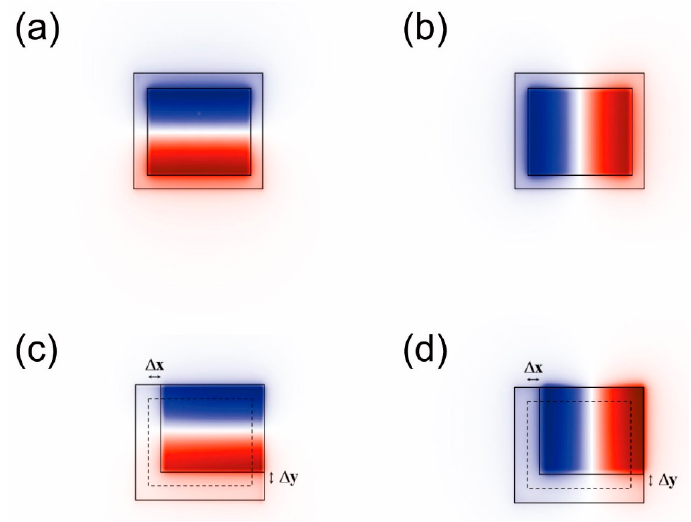
Figure 2. The dominant electric field ( E z ) mode profiles of ( a ) mode 1 (M1) and ( b ) mode 2 (M2) in the cavity with an upper block placed at the center. The mode profiles ( c ) M1 and ( d ) M2 in the cavity with a lateral movement ( Δ x = 30 nm and Δ y = 30 nm) of the upper block. Each mode profile is obtained from the center of the air gap.